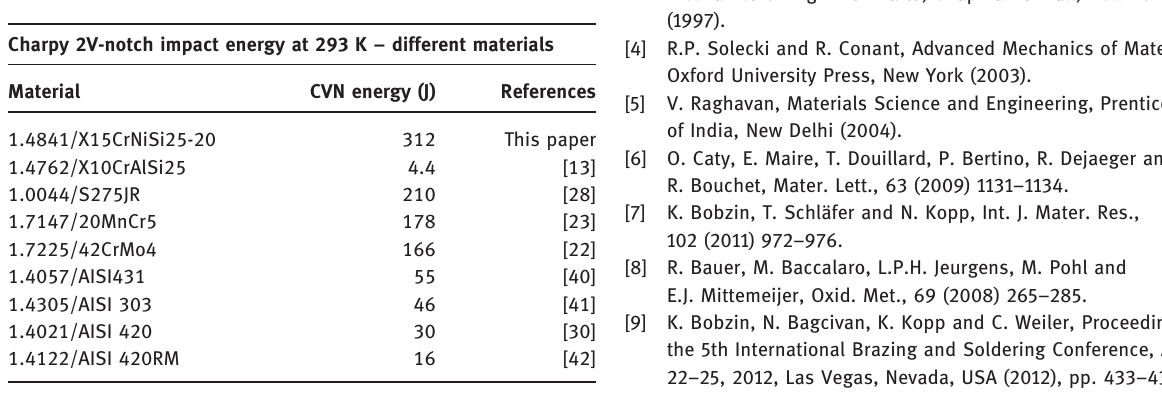
Table 4: Charpy 2V-notch impact energy at 293 K for different